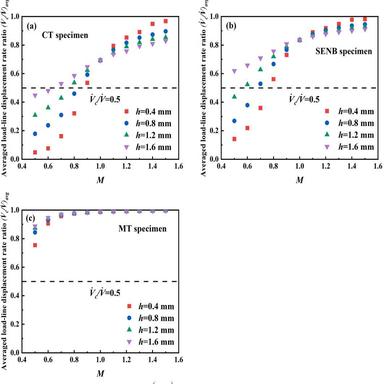
The averaged load-line displacement rate ratio ( V˙ c/V˙ avg for the (a) CT, (b) SENB and (c) MT specimens at all mismatch levels.